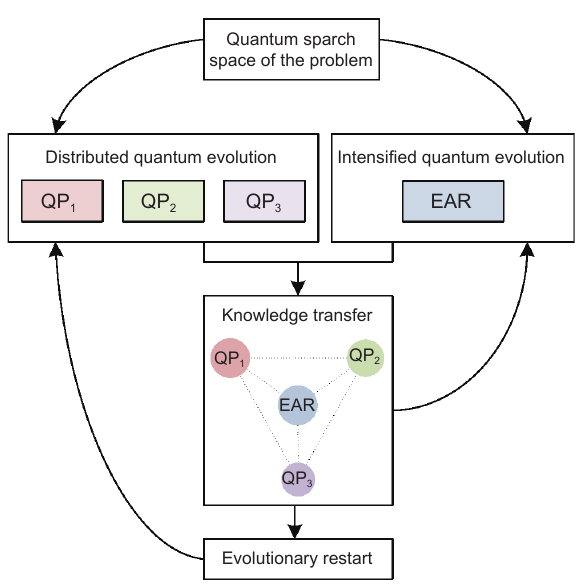
Fig. 1 Distributed memetic evolutionary